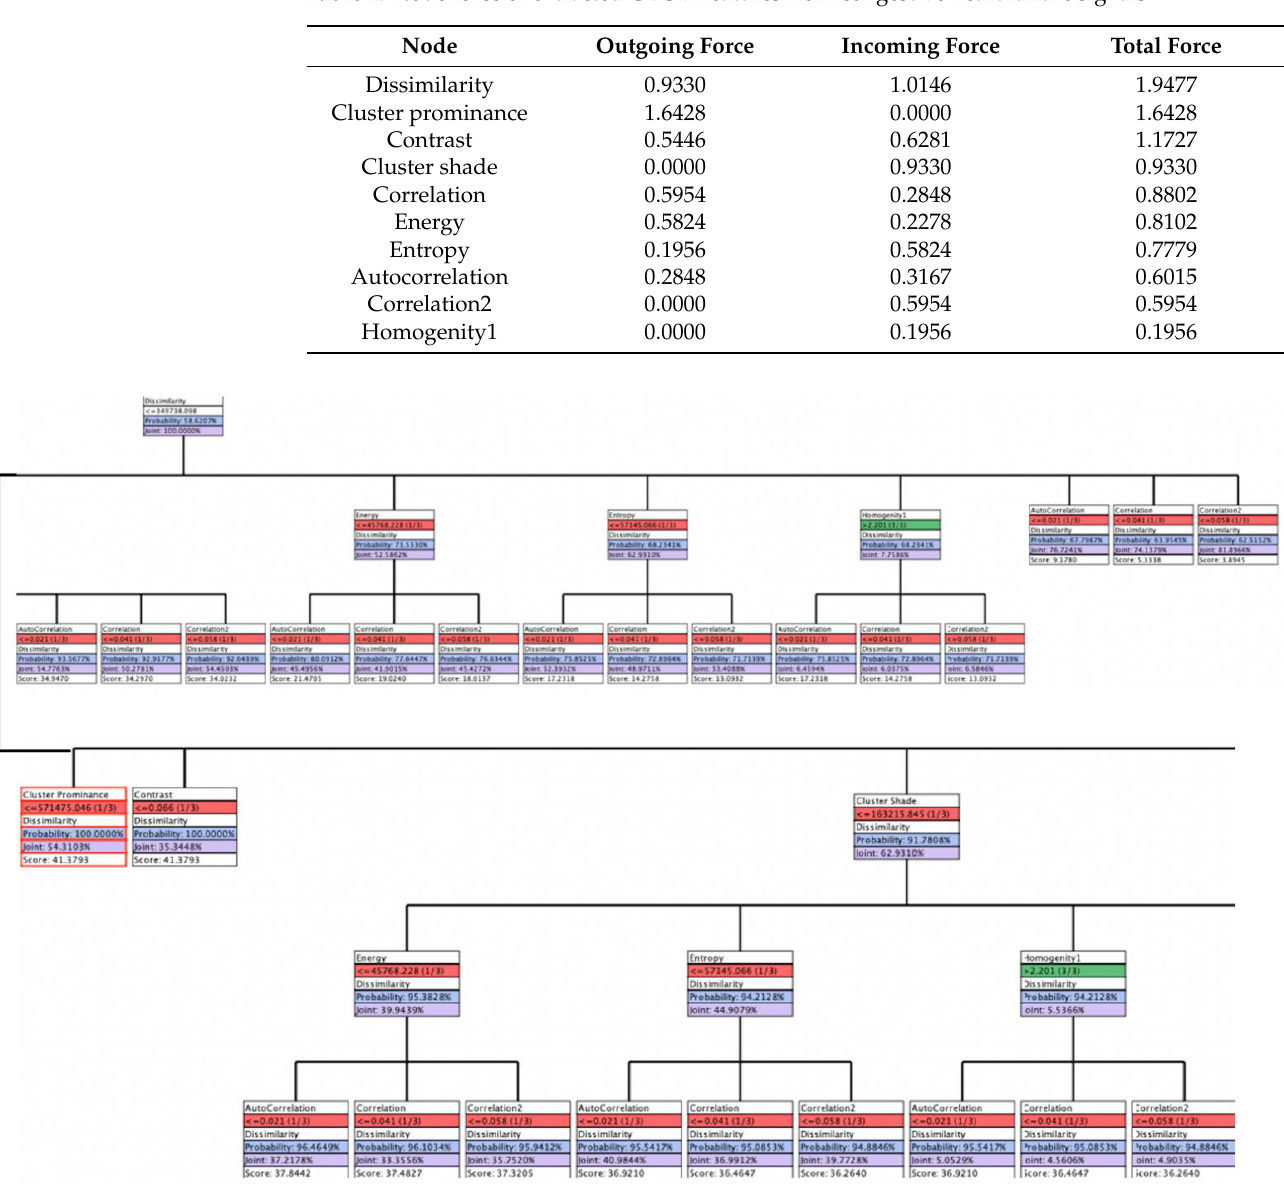
indicates the different cluster states with their occurrence out of the total subjects.